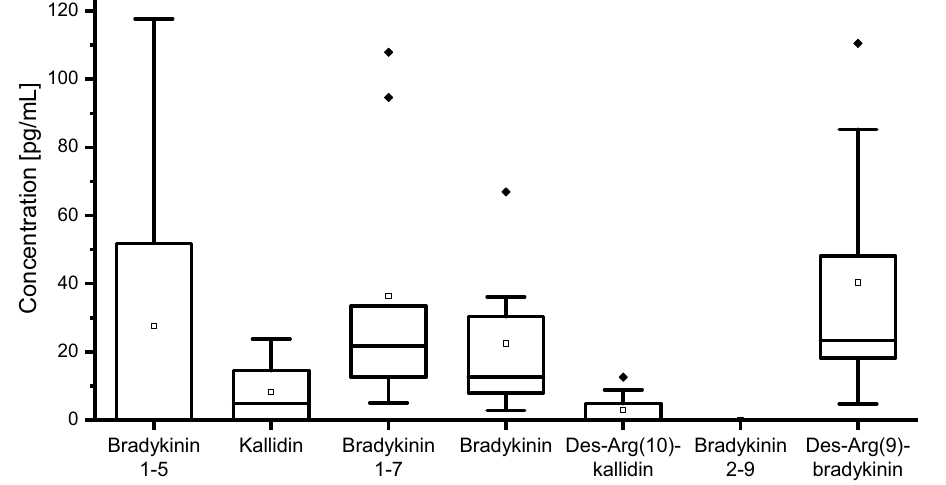
Figure 6. Box plots of the kinin peptide concentrations of healthy volunteers (n = 9) in nasal lavage fluid. Data were normalized to the recovered volume of nasal instillation with 10 mL saline. Filled black square: interquartile range, T: 1.5 interquartile range, –: median, open square: mean, filled black rhombus: